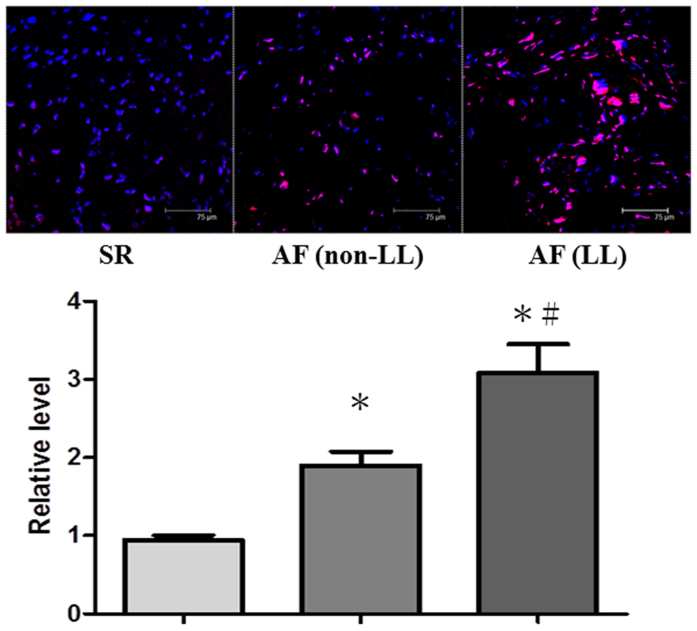
Association of the CCTTT repeat length polymorphisms with oxidative stress in AF tissues.Atrial tissues were stained with dihydroethidium to detect ROS generation as described in the Methods section. Representative confocal images show ROS production in the atria of seven AF patients (4 non-LL and 3 LL) and two controls (with sinus rhythm [SR]). Relative fluorescence density in the α-actin-expressing area was quantified (right). Data are expressed as mean ± SE. *Represents significant differences versus the controls (P = 0.001 for non-LL versus SR, P < 0.001 for LL versus SR). #Represents significant differences between non-LL and LL groups (P < 0.001). One-way ANOVA with post hoc Tukey’s tests was applied for two groups and multiple comparisons.